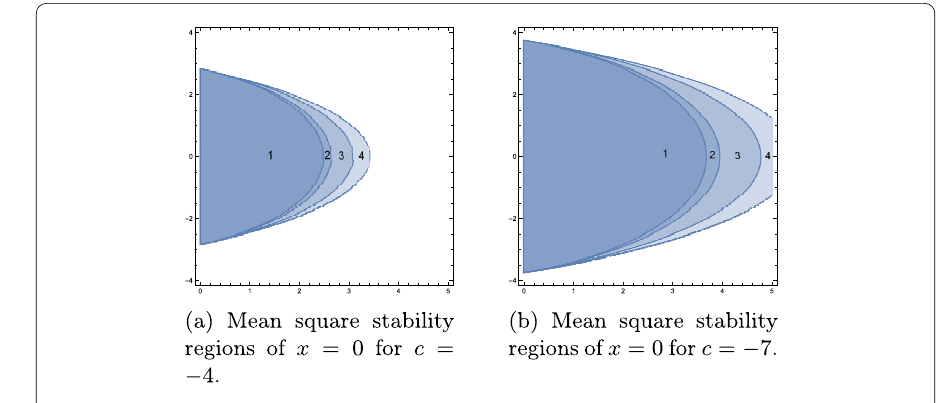
Figure 2 Regions of mean square stability of the zero solution of (34)